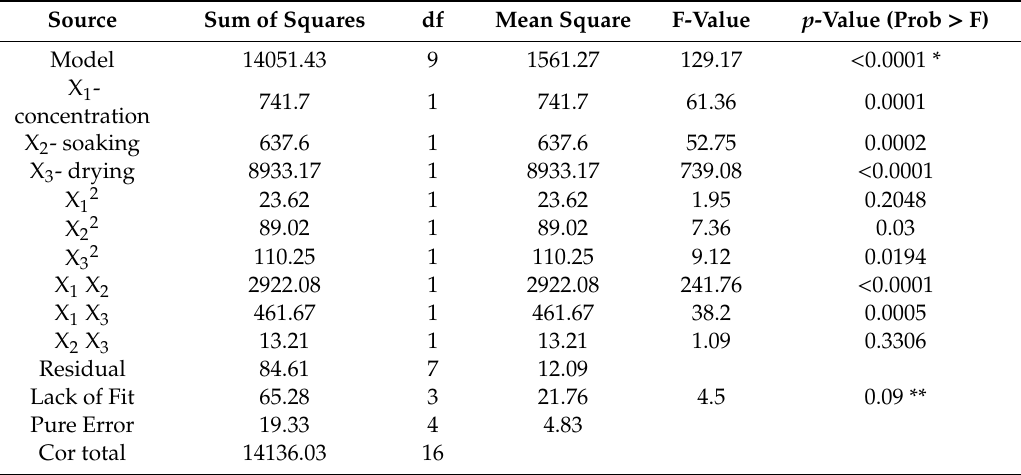
Table 6. ANOVA of the quadratic model for alkaline treatment of